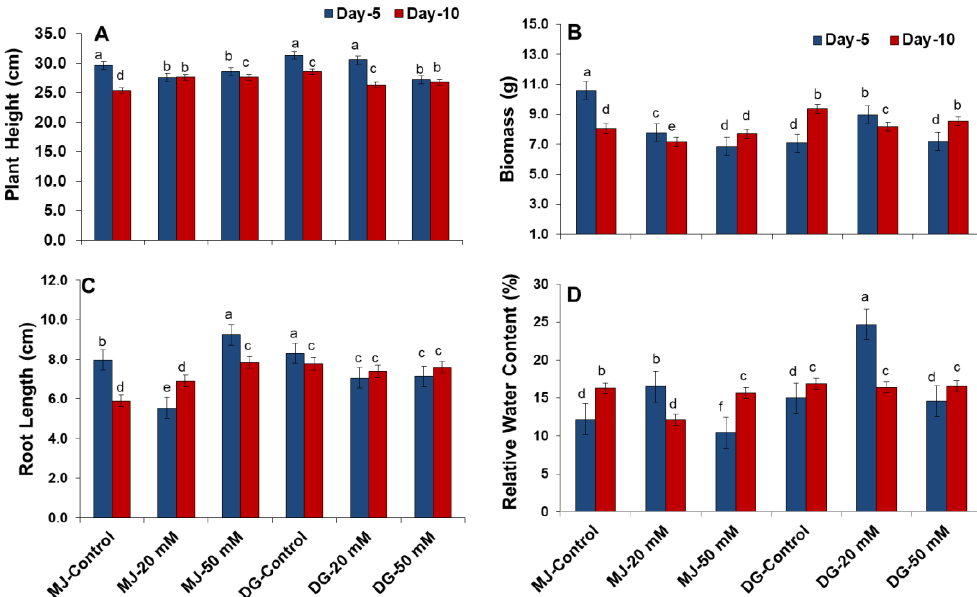
Figure 2. ( A ) Plant height, ( B ) biomass, ( C ) root length, and ( D ) relative water content in spinach genotypes Delhi green (DG) and Malav Jyoti (MJ). Results are presented for the controls (MJ control; DG control), 20 mM of NaCl treatments (MJ-20 mM; DG-20 mM), and 50 mM of NaCl treatments (MJ-50 mM; DG-50 mM). Vertical bars indicate mean ± S.E. for n = 3. Means with different letters are significantly different at p ≤ 0.05 according to the Tukey’s studentized range test. The blue color bars indicate the day 5 results and the red color bars indicate the day 10 results.